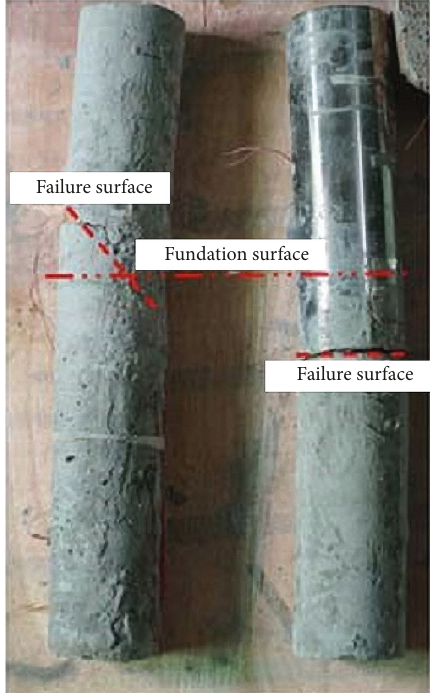
Figure 14: Comparison of failure modes of the two rock-socketed